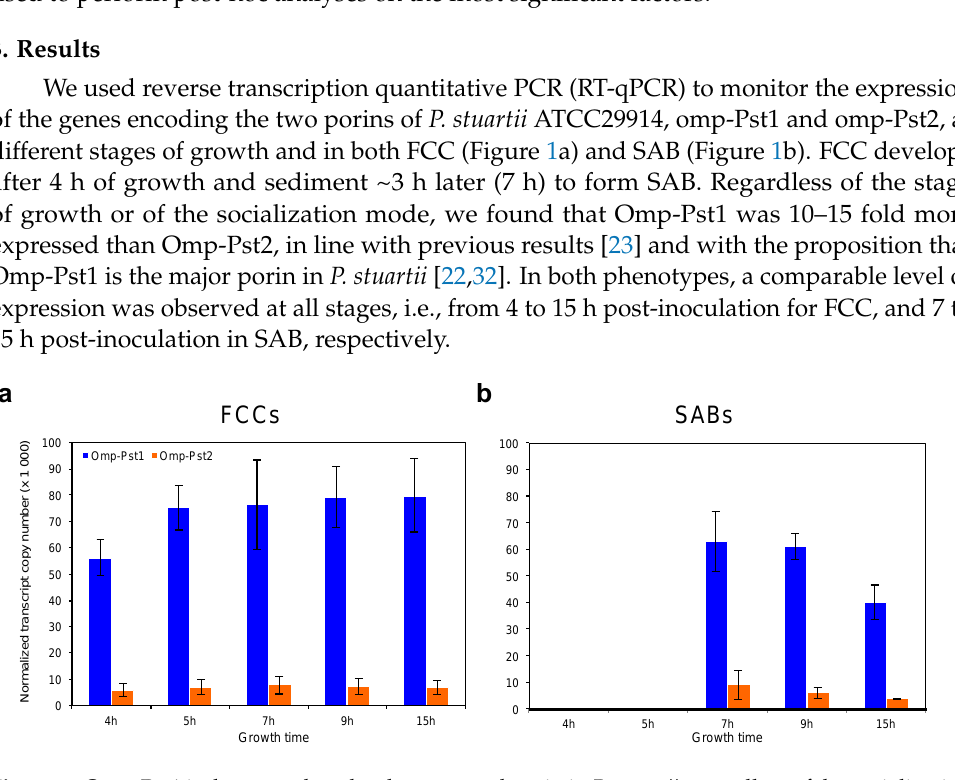
Figure 1. Omp-Pst1 is the most abundantly expressed porin in P. stuartii , regardless of the socialization mode. Expression of omp-Pst1 (blue) and omp-Pst2 (orange) porins was monitored by RT-qPCR, at different stages of growth, and both in FCC (panel ( a )) and SAB ( b ). Reported numbers of normalized transcript copies were each averaged over three biological replicates; errors bars outline the standard deviation of measurements.